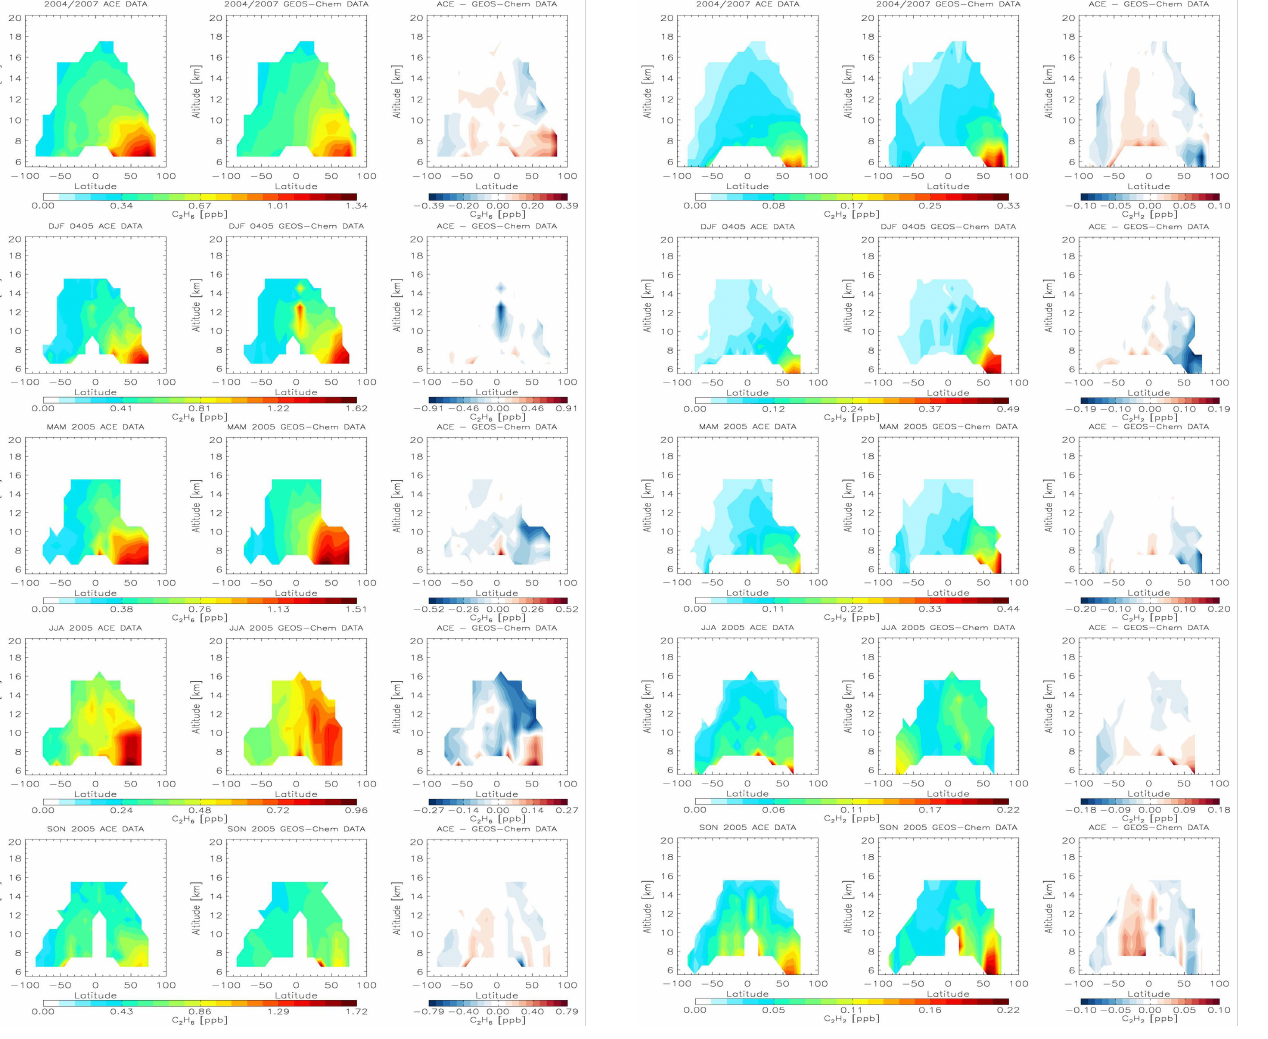
Fig. 9. C 2 H 6 altitude-latitude cross sections from ACE left col- umn, GEOS-Chem central column and difference between both data sets right column. Top panel full study time period, second panel